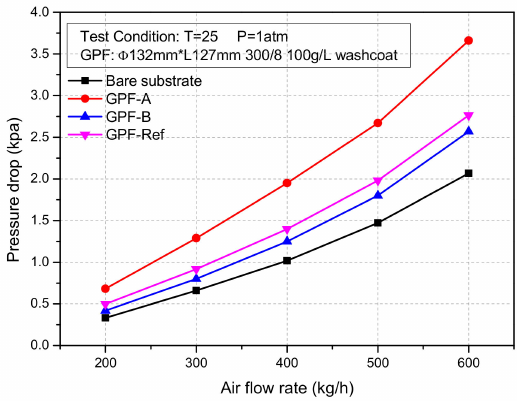
Figure 3. Influence of washcoat material bulk density on pressure